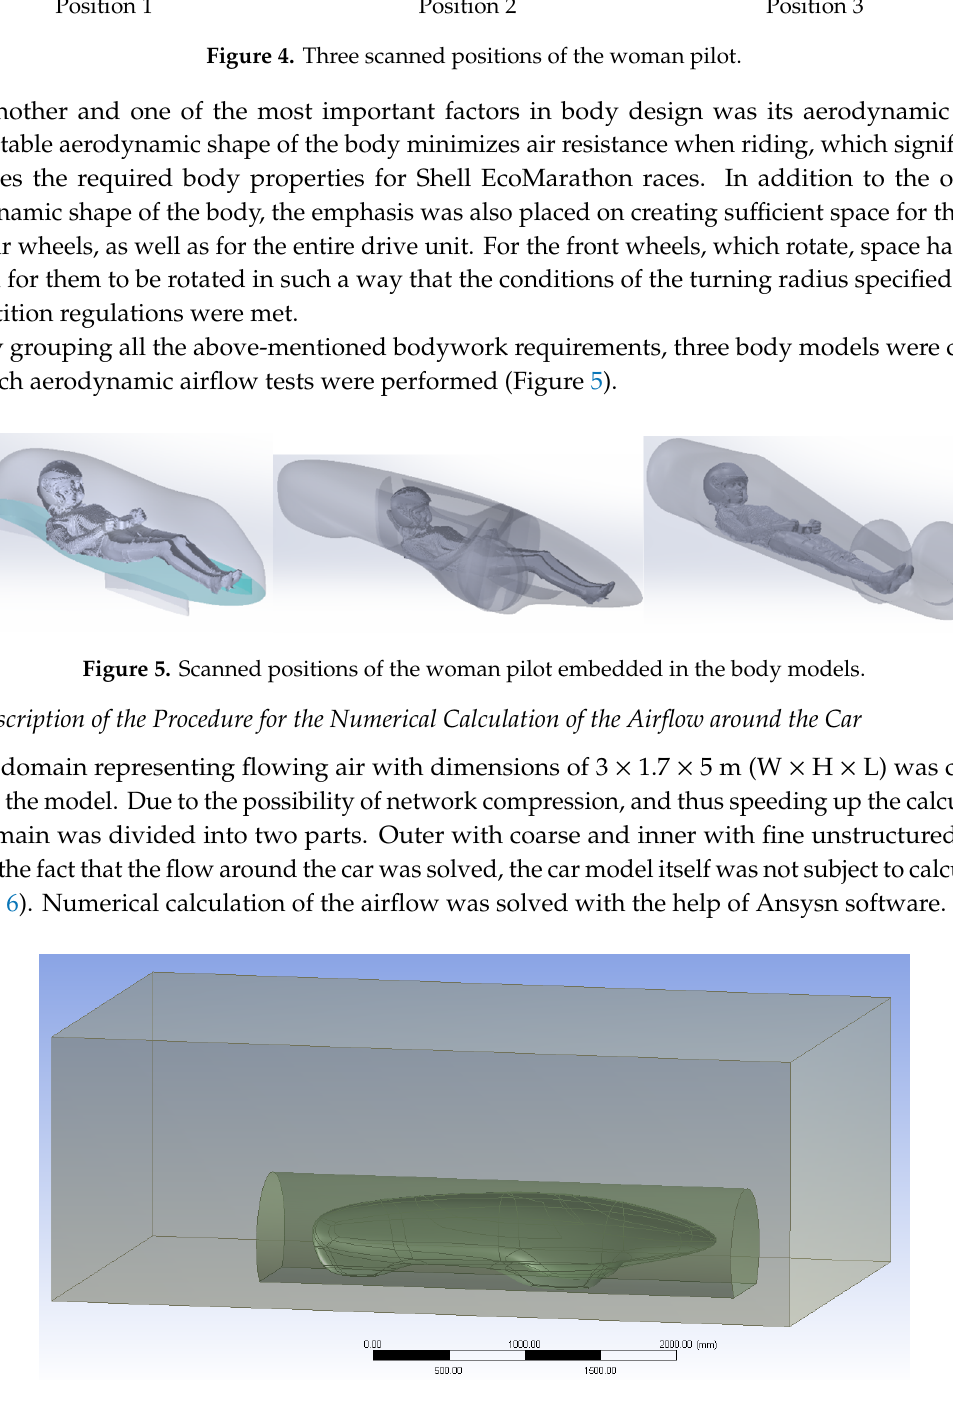
Figure 6. 3D model for numerical solution of flow.